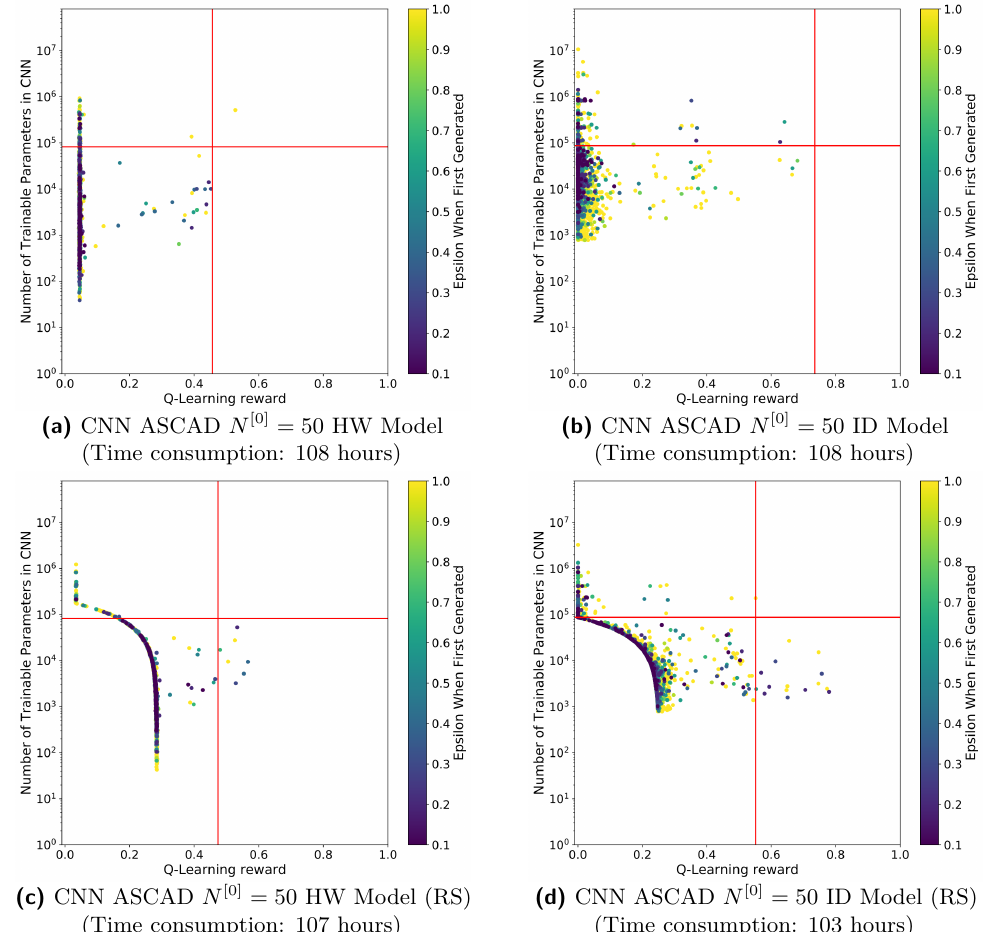
Figure 13: ASCAD N [0] = 50 : An overview of the number of trainable parameters, reward, and the ε a CNN was first generated for the ASCAD N [0] = 50 experiments. The red lines indicate the amount of trainable parameters and the Q-Learning Reward of the state-of-the-art CNNs from Zaid et